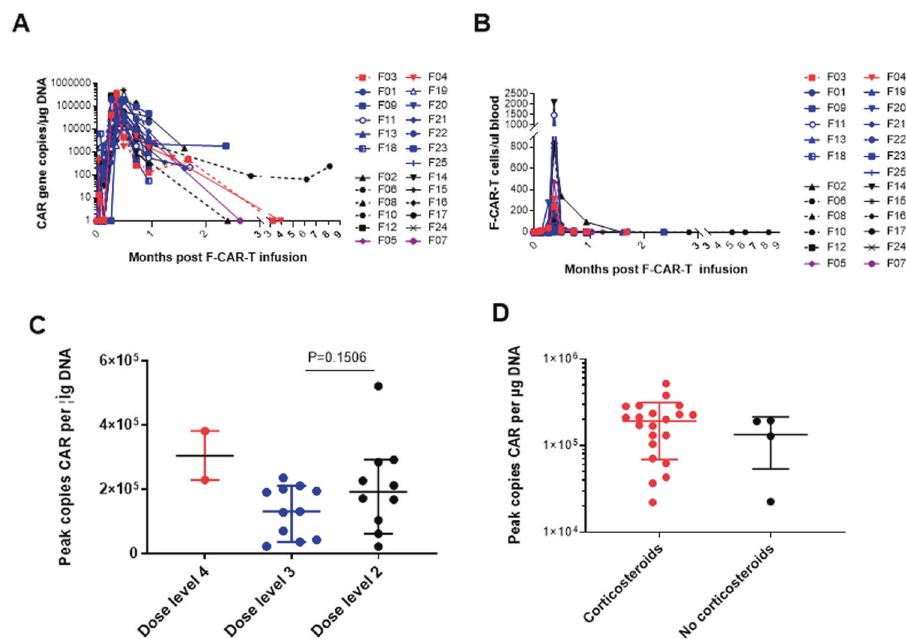
Fig. 3 Cellular kinetics of F-CAR-T in patients. A F-CAR-T cells in peripheral blood by qPCR. Purple, dose level 1; black, dose level 2; blue, dose level 3; red, dose level 4; B F-CAR-T cells in peripheral blood by fl ow cytometry. Purple, dose level 1; black, dose level 2; blue, dose level 3; red, dose level 4; C Comparison of the mean peak copy number of F-CAR-T cells in peripheral blood at each dose level. Statistical signi fi cance was determined by the Mann – Whitney test. D Comparison of the mean peak copy number of F-CAR-T cells in peripheral blood with or without steroids. Statistical signi fi cance was determined by the Mann – Whitney